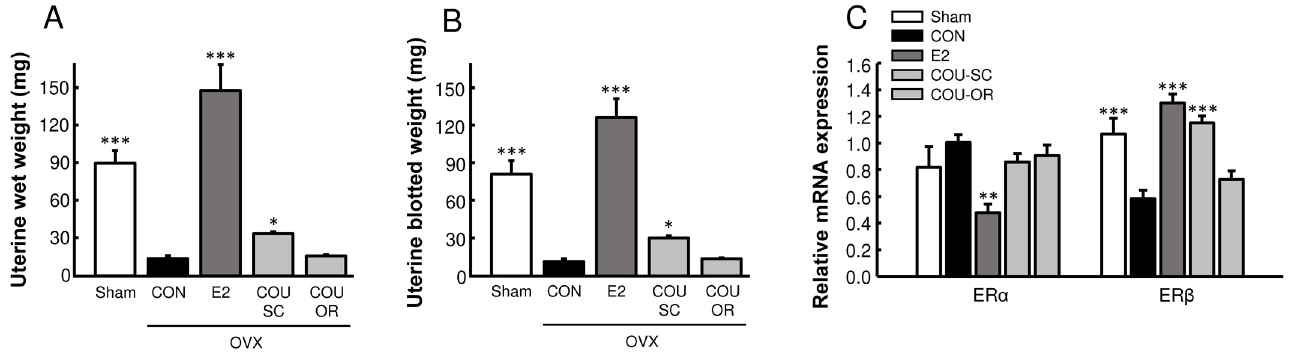
Figure 1. Effects of coumestrol on uterine growth in OVX mice. Mice were subjected to sham or ovariectomy surgery and received the indicated sample treatments for 10 weeks. At the end of the study, the ( A ) uterine wet and ( B ) blotted weights were recorded. ( C ) Uterine mRNA expression of estrogen receptors (ER α and ER β ). Values represent means ± SEM ( n = 7). Con, control; E2, 17 β -estradiol; COU-SC, coumestrol subcutaneous treatment; COU-OR, coumestrol oral treatment; OVX, ovariectomized. * Significantly different from the OVX control group (* p < 0.05, ** p < 0.01, *** p < 0.001).